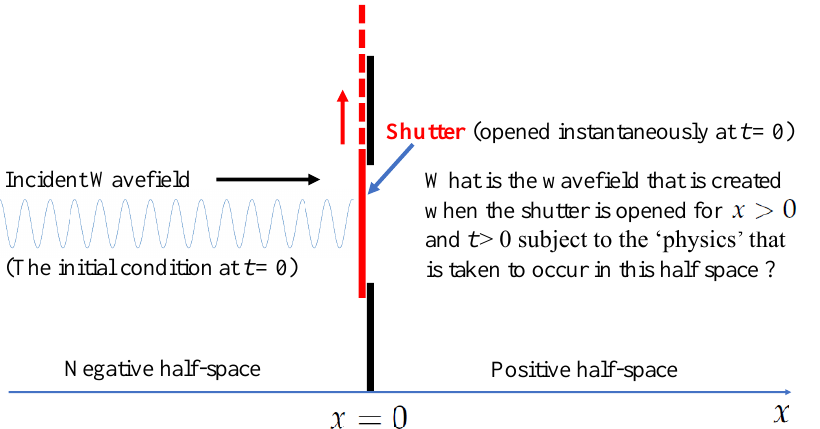
Figure 1. Schematic diagram of the shutter problem for which the following question is relevant: What is the wave-field generated in the positive half-space when the shutter is opened instantaneously at t = 0, subject to the ‘physics’ (quantified by the partial differential equation which defines the physical model) that is taken to